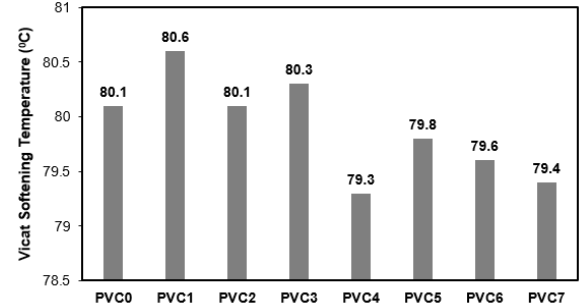
Figure 5: Effects of individual, binary and multiple combinations of flame retardants on PVCs’ Vicat softening